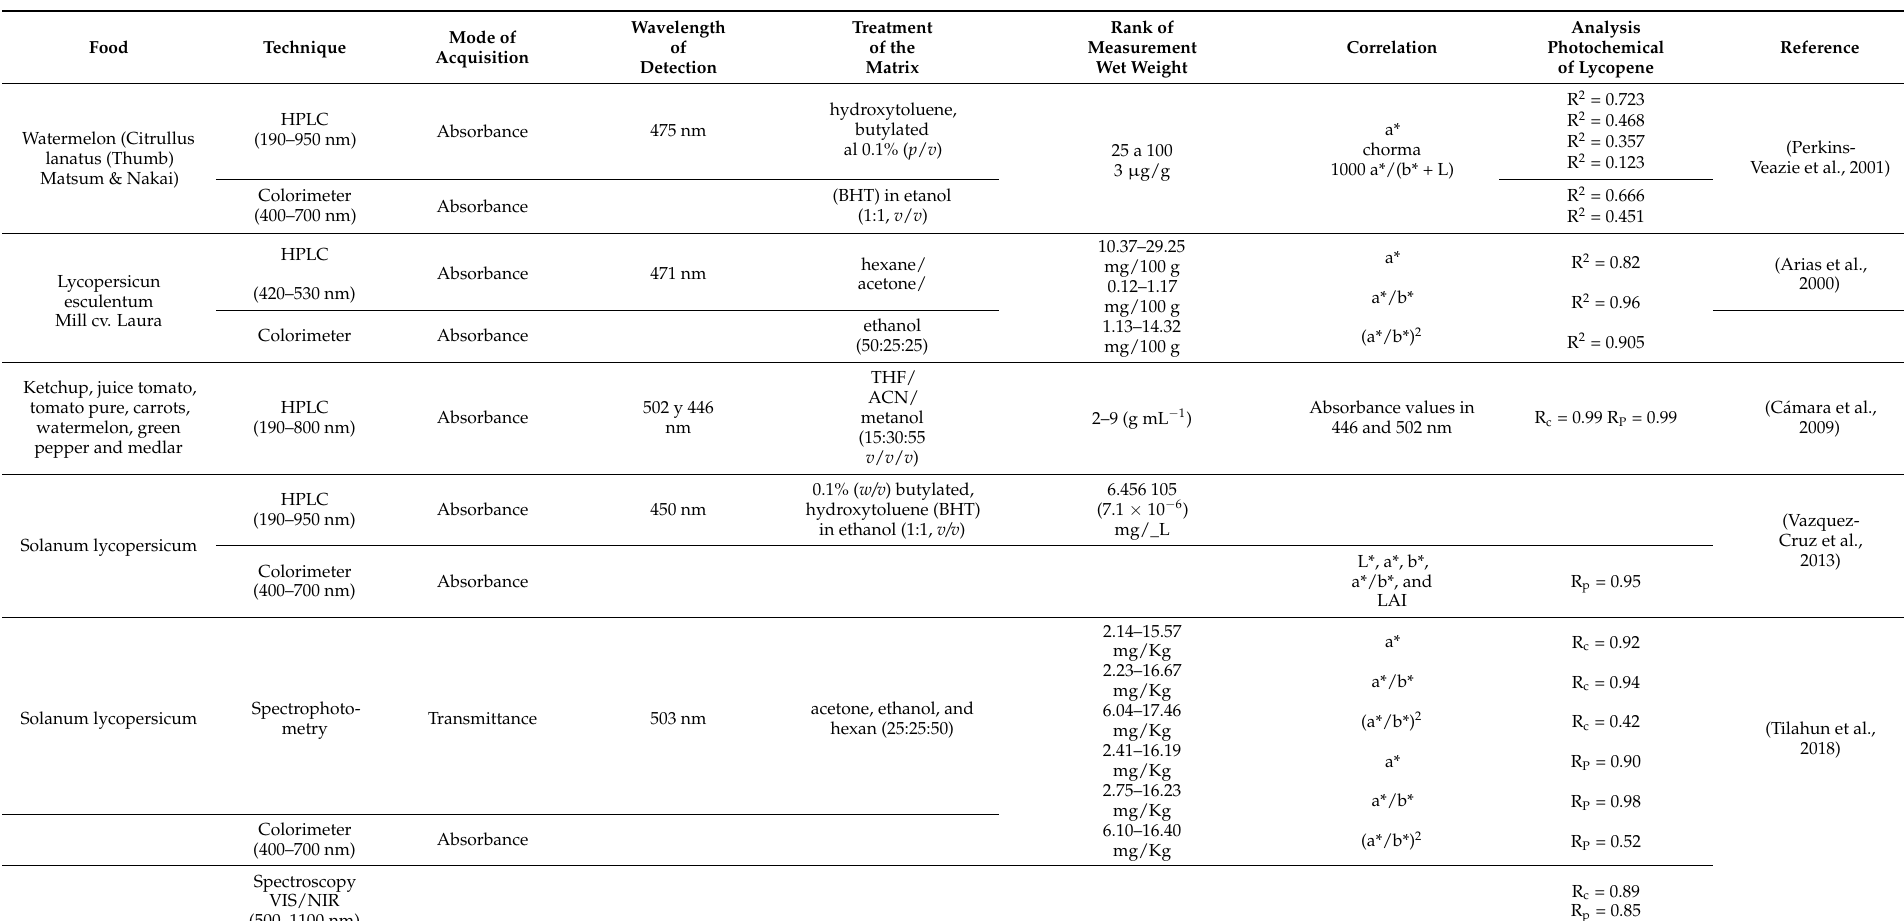
Table 4. Comparison of lycopene detection and measurement